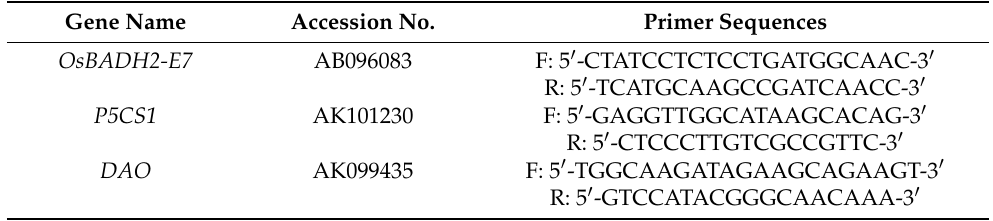
Table 1. Primer sequences of